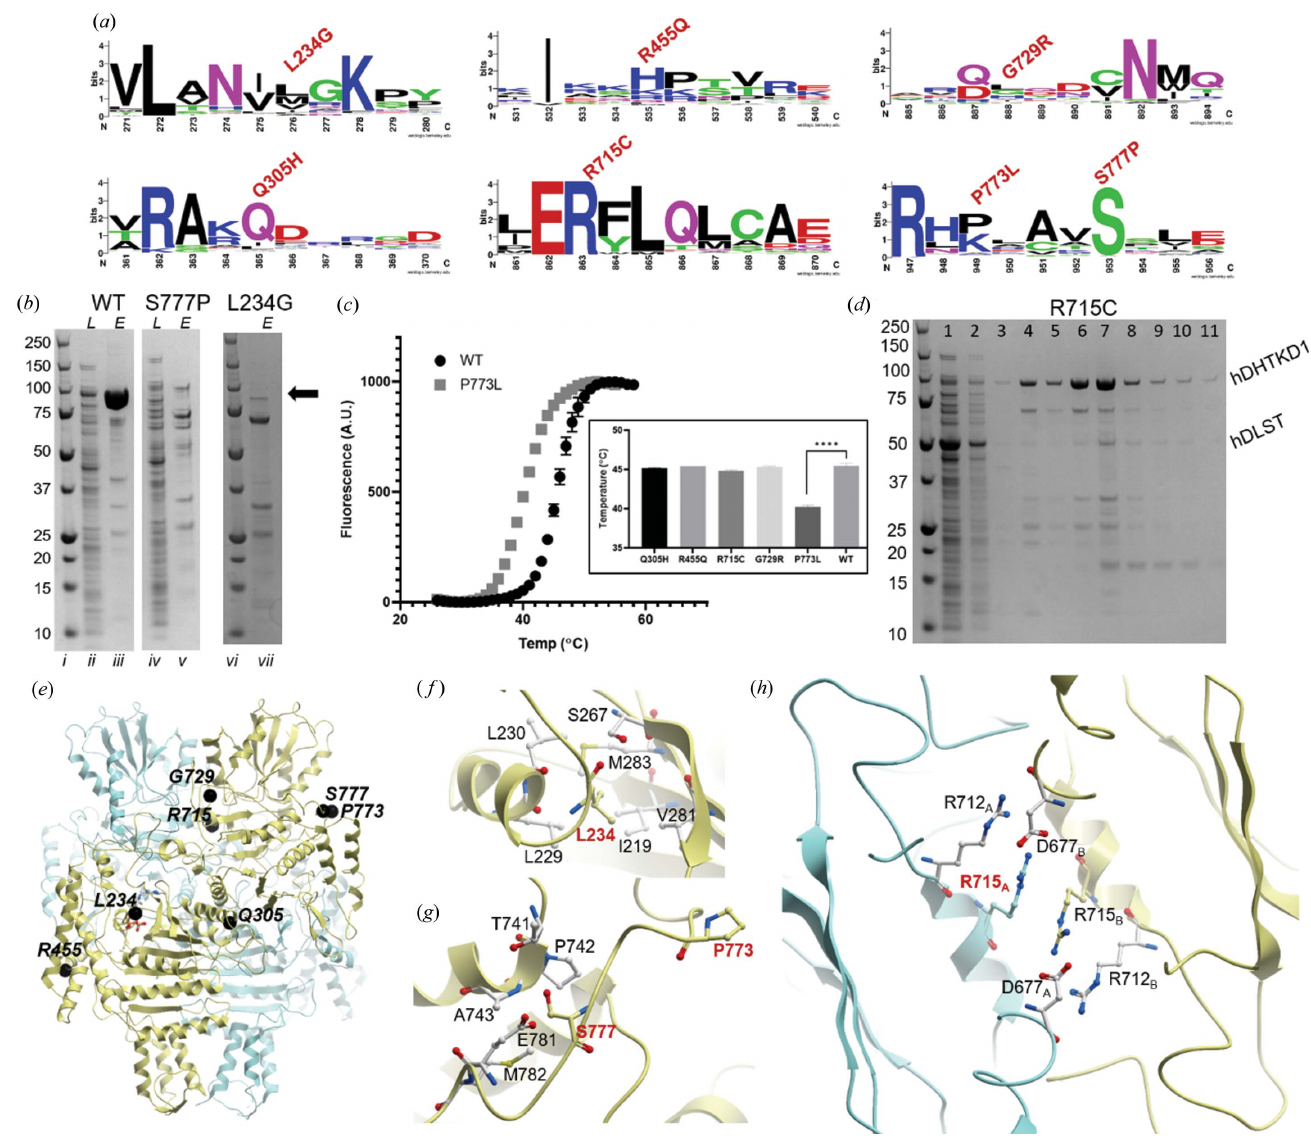
Figure 4 Characterization of hDHTKD1 disease-causing variants. ( a ) Weblogo diagrams generated from an alignment of >100 DHTKD1 orthologues and homologues, showing sequence conservation for the regions surrounding the seven missense mutation sites. ( b ) Small-scale expression and purification for hDHTKD1 WT and variants. SDS–PAGE gel slices showing lysate ( L ) and eluant ( E ) samples from affinity purification of hDHTKD1 45–919 WT, p.S777P and p.L234G. The position of the hDHTKD1 bands is marked by an arrow. Original uncropped gels are shown in Fig. S13 (lanes i – v were cropped from one gel and lanes vi – vii were cropped from another). ( c ) DSF melting curves for hDHTKD1 45–919 WTand p.P773L, with an inset showing the derived melting temperature ( T m ) values for WTand five variants. ( d ) Affinity pulldown of hDLST 68–453 by immobilized His-tagged hDHTKD1 45–919 p.R715C variant. The SDS–PAGE shown is one of two biological replicates (Fig. S15). The lanes are loaded with the following samples: 1, flow through; 2–6, wash fractions of increasing imidazole concentration; and 7–11, elution fractions with 250 m M imidazole. ( e ) hDHTKD1 homodimer showing the sites of the seven missense mutations (black spheres) on one subunit (yellow ribbon). ( f )–( h ) Atomic environments surrounding the mutation sites ( f ) p.L234G, ( g ) p.P773L and p.S777P, and ( h ) p.R715C. All amino acids shown, including sites of missense mutations, are of the WT